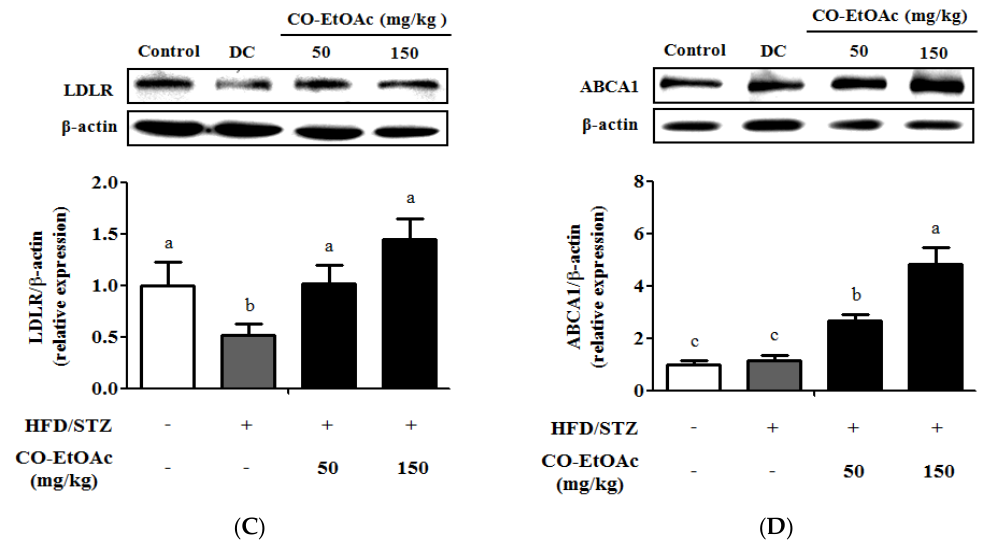
Figure 4. Effects of OE ‐ EtOAc on the levels of hepatic cholesterol and gene expression. ( A ) The content of hepatic cholesterol was analyzed using enzymatic assay. ( B ) Relative mRNA levels of hepatic SREBP ‐ 2 , HMG ‐ CoAR , LDLR , SR ‐ B1 , ABCA1 , and CYP7A1 were analyzed using RT ‐ qPCR. ( C ) Relative protein levels of hepatic LDLR and ABCA1 were detected by Western blot analysis. Data are represented as mean ± SEM ( n = 8–10). Values with different letters show significant difference ( p < 0.05) by analysis of variance (ANOVA) followed by Duncan’s multiple range tests. Quantitative values of mRNA and protein expression are expressed as folds of the control group, which is set as 1.